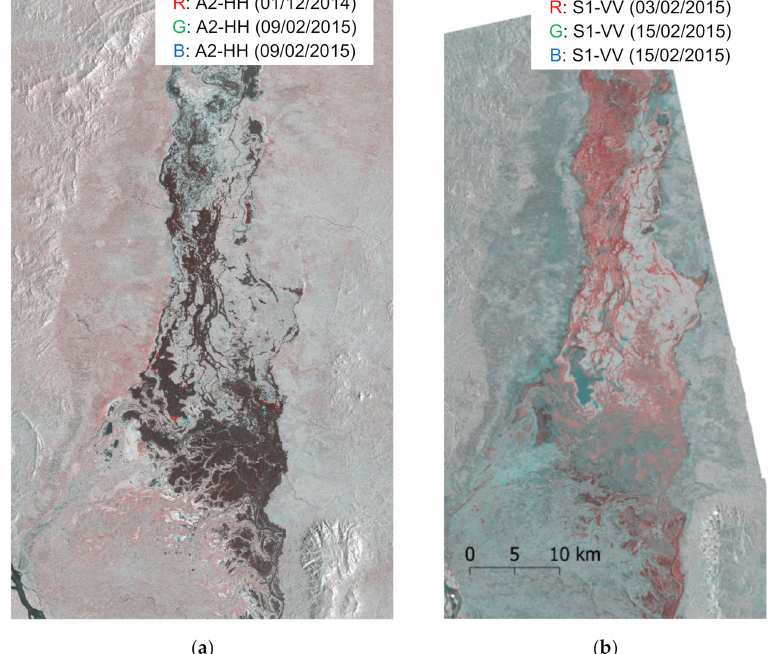
Figure 6. ( a ) RGB combination of the two S1 images acquired on 3 (red) and 15 (green and blue channels) February 2015. ( b ) RGB combination of the A2 images acquired on 1 December 2014 (red) and 9 February 2015 (green and blue